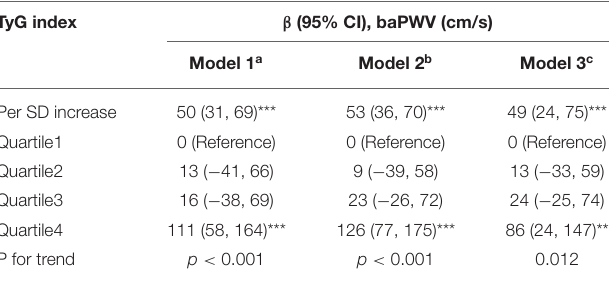
TABLE 3 | Linear regression analyses for the association between TyG index and baPWV.